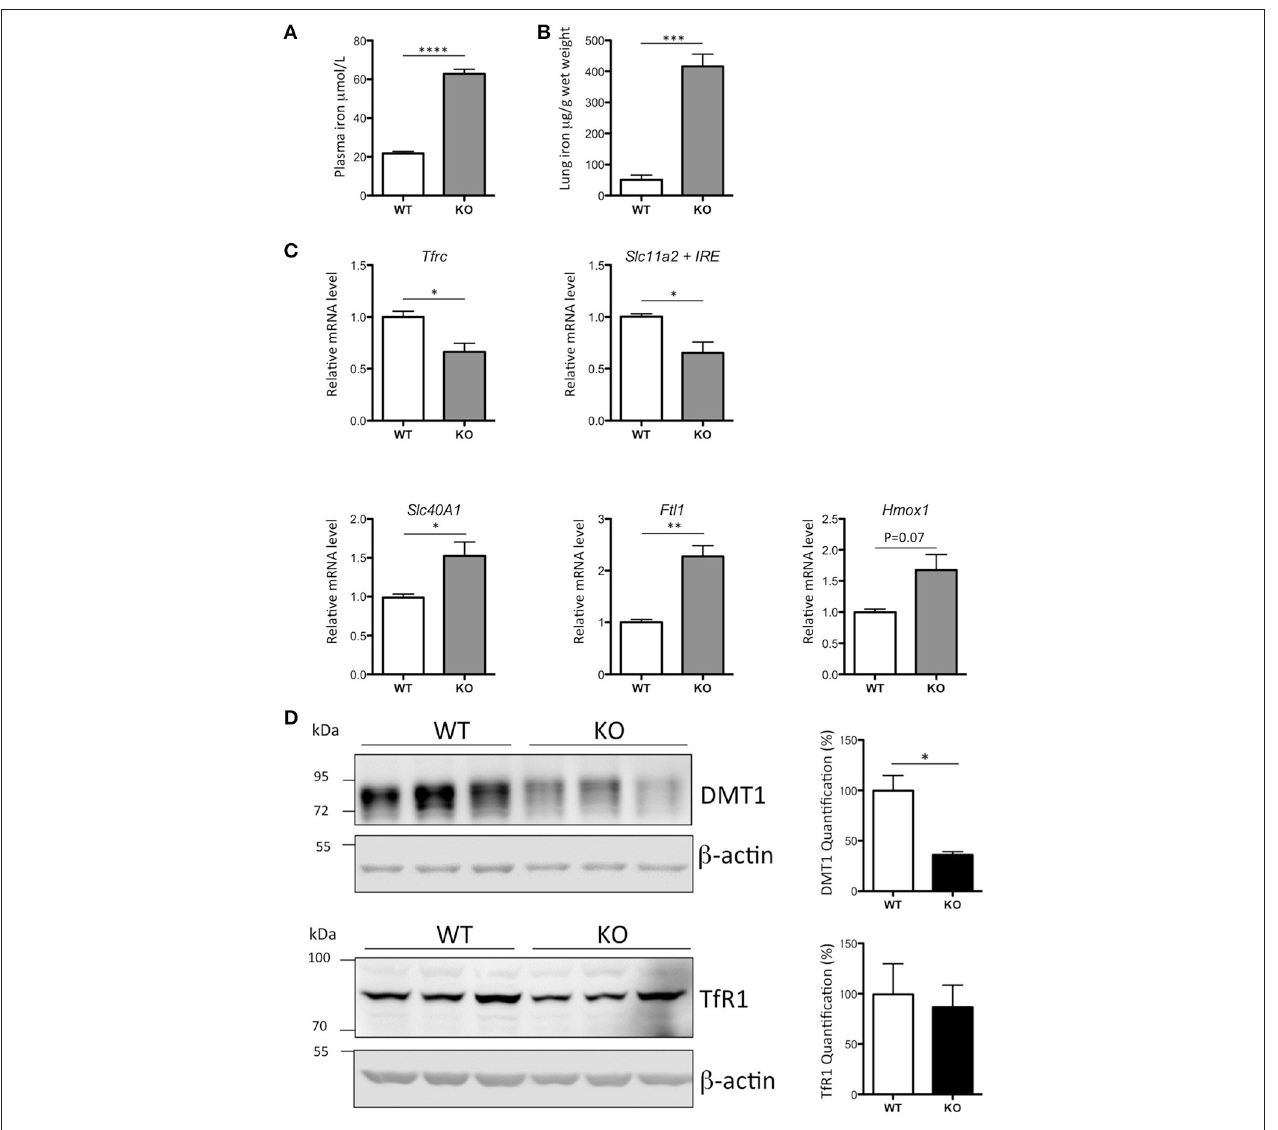
FIGURE 1 | Iron load phenotype in the lung of WT and Hepc KO mice: Plasma iron in µ M (A) and lung iron in µ g/g wet tissue (B) . Pulmonary Tfrc , Slc11a2 + IRE, Slc40A1 , Ftl1, and Hmox1 mRNA levels relative to Ppia analyzed by real-time PCR. Changes are expressed relative to WT mice (C) . Lung DMT1 and TfR1 protein levels analyzed by WB using proteins from membrane enriched-fractions (D) . Expression is normalized to beta actin and quantified using Image J. Quantification of the blots are presented in % (100% set for WT). Error bars represent SEM for n = 3 mice in each group. Statistical significance is indicated by asterisks (* p < 0.05, ** p < 0.01, *** p < 0.001, **** p < 0.0001). Similar results were obtained in at least two independent